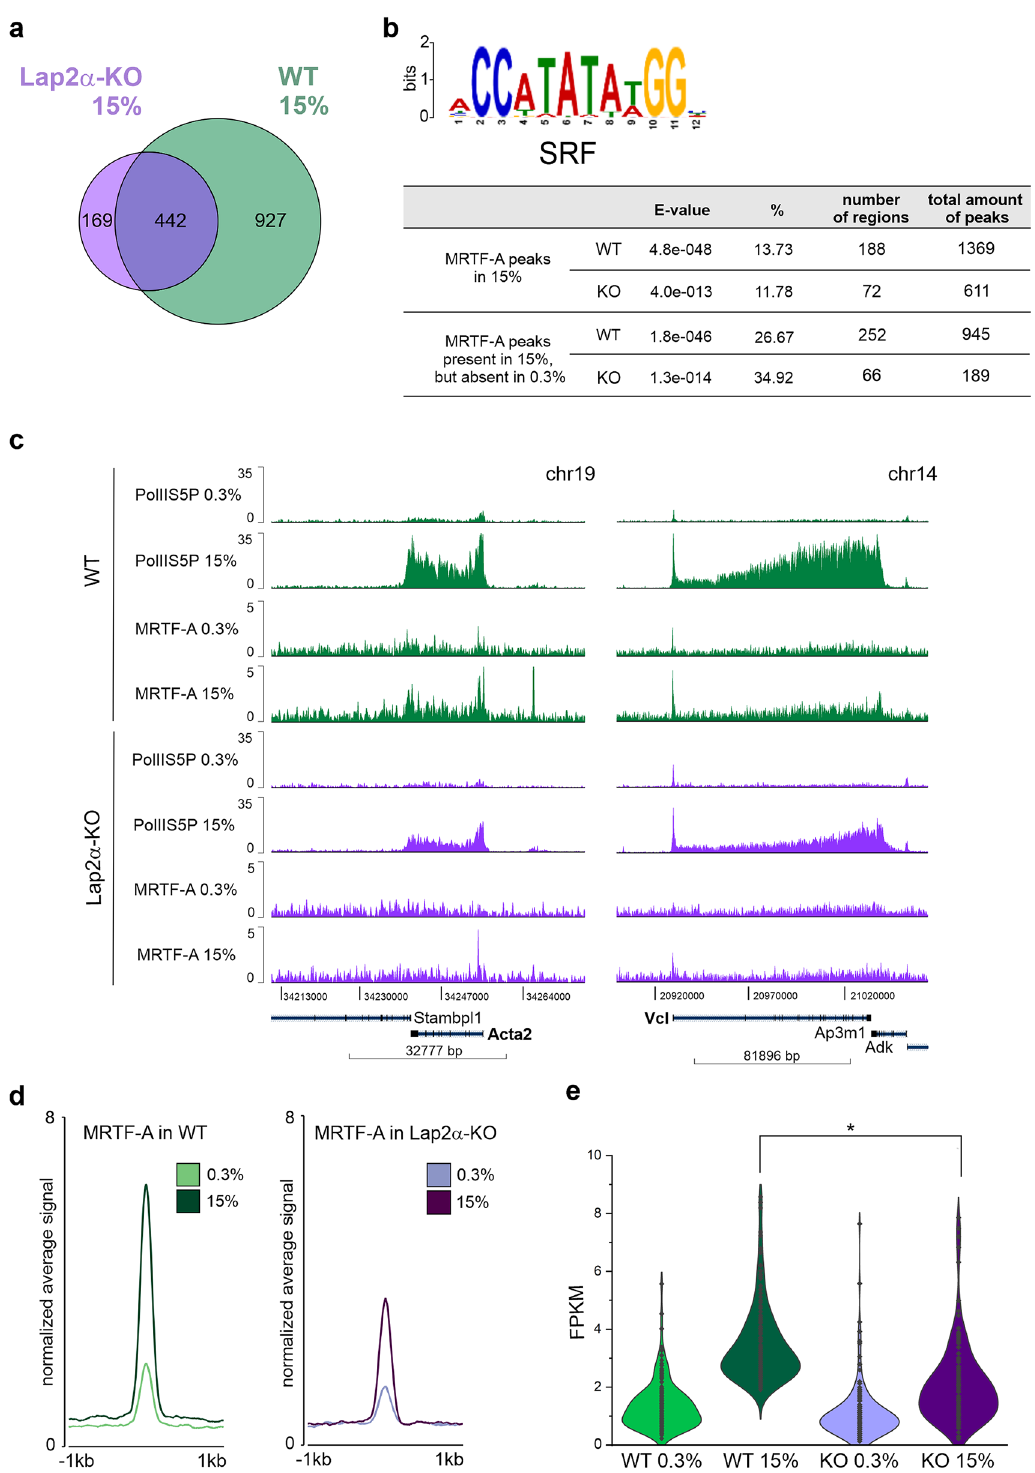
Figure 4. Lap2α is required for MRTF-A recruitment to SRF target genes. (a) Venn diagram showing overlap of MRTF-A peaks in WT and Lap2α KO cells under serum-stimulated (15%) conditions from chromatin immunoprecipitation followed by deep- sequencing (ChIP-seq). (b) MEME-ChIP analysis identifies SRF motif (upper part) within the MRTF-A peaks found in 15% FBS (upper table) and peaks present in 15% FBS but absent in 0.3% FBS (lower table). (c) Normalized (FPKM) coverage of Pol II S5P and MRTF-A on MRTF-A target genes Acta2 and Vcl in Lap2α WT and KO MDFs in serum-starved (0.3%) and stimulated (15%) conditions. (d) Coverage of MRTF-A on the peaks with SRF motif in Lap2α WT vs KO cells in serum-starved (0.3%) and serum- stimulated (15%) conditions. Metaprofiles with average normalized fragment counts are centered on peak summits of MRTF-A in Lap2α WT in 15%. (e) Violin plots showing distribution of MRTF-A average normalized read counts (FPKM) at identified SRF binding sites in 15% (N = 155) at 400 bp in Lap2α WT vs KO cells in serum-starved (0.3%) and serum-stimulated (15%) conditions. Statistically significant differences (*) tested by Mann–Whitney U test P < 0.00001. See also Supplementary